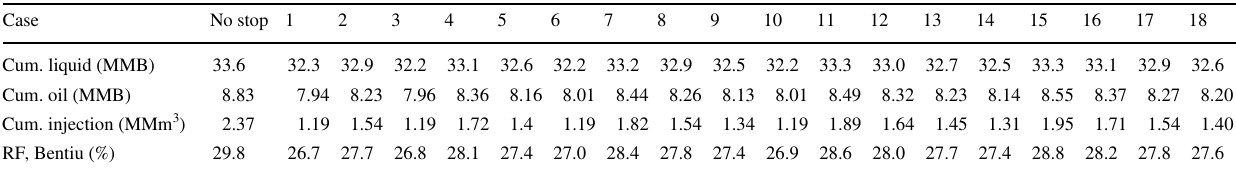
Table 13 Forecast result of SG open and stop time optimization cases